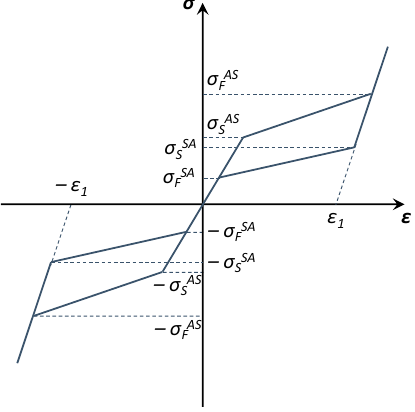
Figure 1. Theoretical stress-strain curve for a shape memory alloy (SMA).